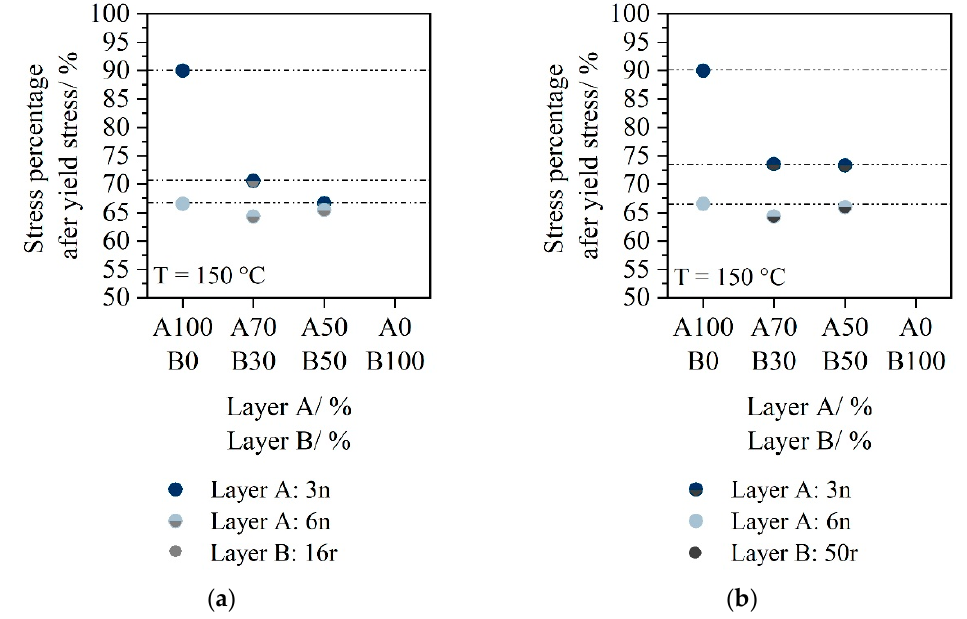
Figure 7. Stress drop after yield stress for two-layer sheets stretched at 150 °C for material 16r as Layer B ( a ) material 50r as Layer B ( b ).